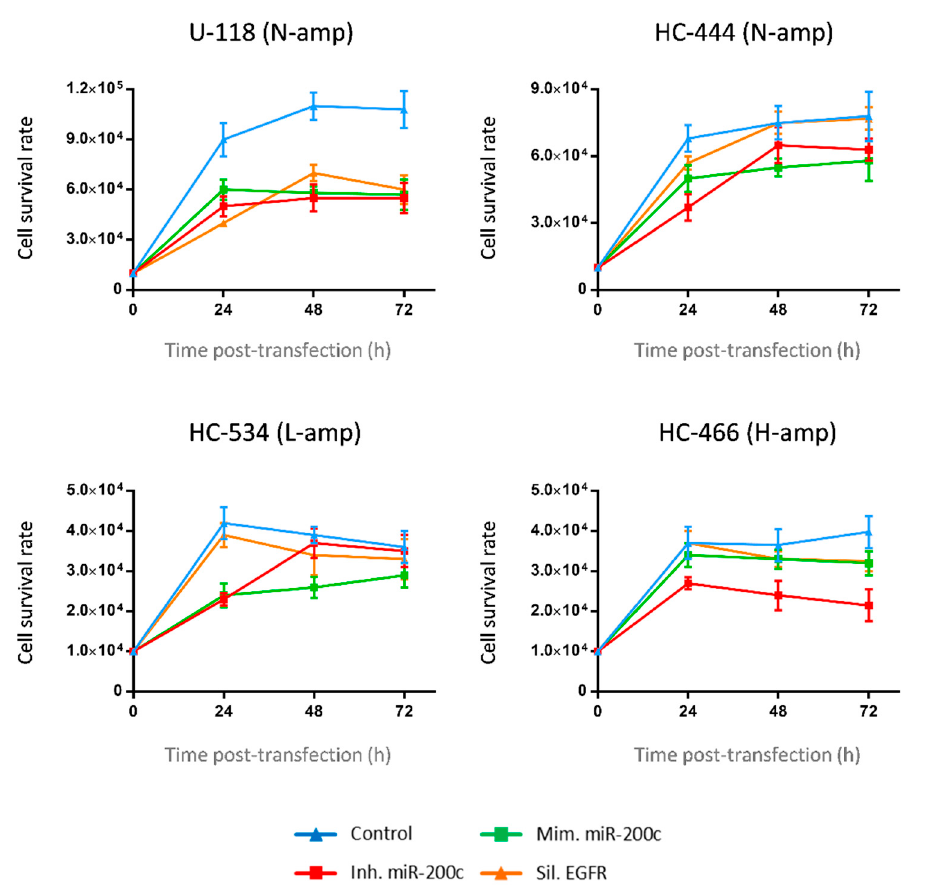
Figure 4. Cell viability. Cell viability study by luminescence in the four transfected cell cultures (U-118, HC-444, HC-534 and HC-466) with miR-200c mimic, miR-200c inhibitor and EGFR silencer conditions, with respect to control (h: hours). The points for each curve represent the mean values ± SDs of three independent experiments. Statistical analyses were performed using one-way analysis of variance, followed by Dunnett’s t-test for multiple comparisons.